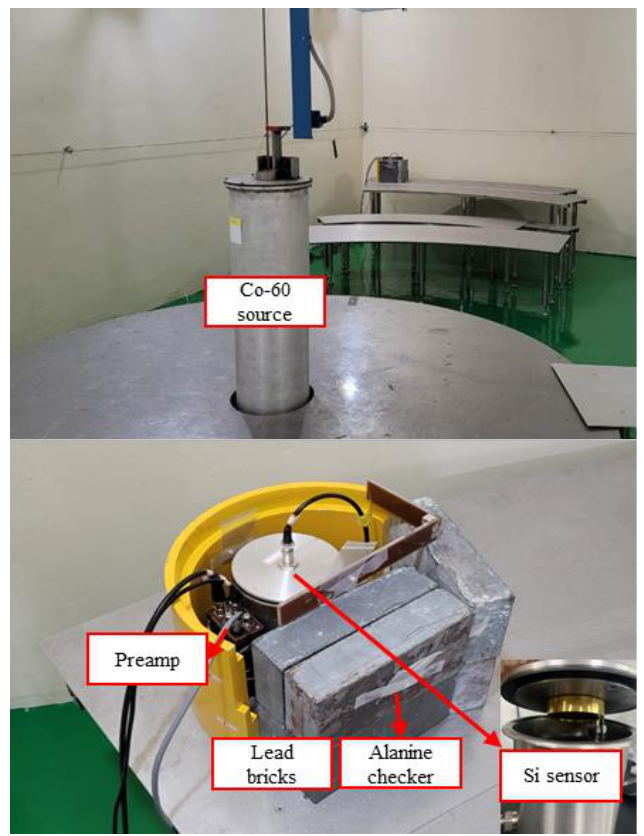
Fig. 4. Radiation hardness experiment on the silicon sensor and preamplifier at KAERI ARIT facility